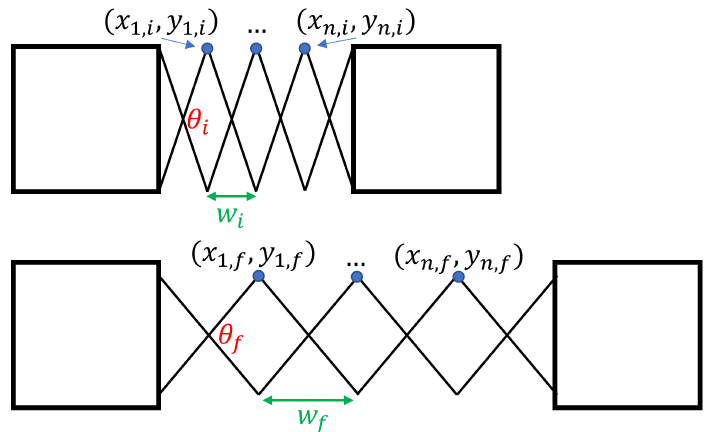
Figure 9. The movement of an entire scissor-hinge